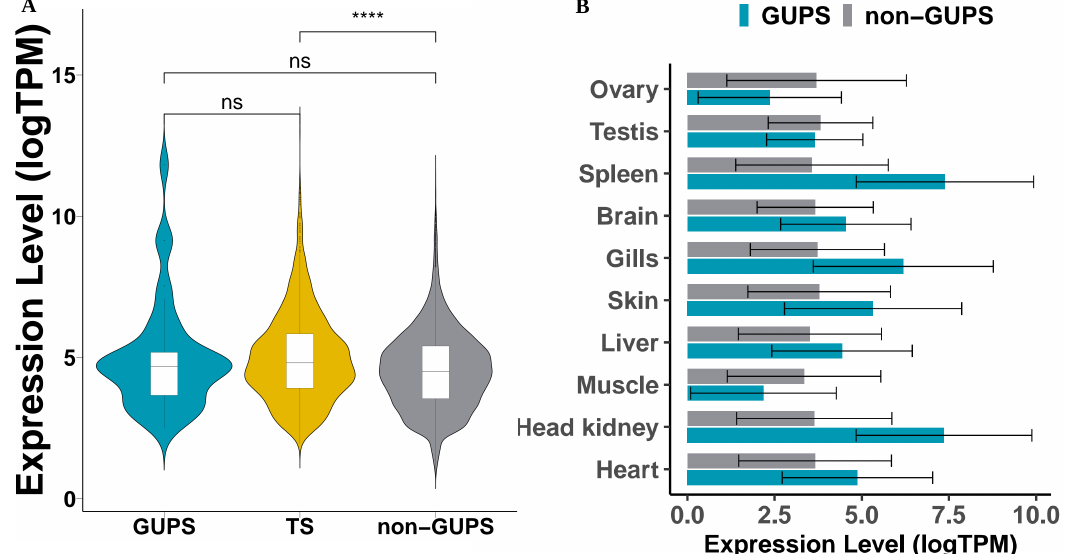
Figure 7. Expression levels of GUPS in pikeperch. ( A ), Violin plot comparing log transformed expression levels of GUPS, TS (Tissue-specific) and non-GUPS (all genes not under positive selection). The expression levels between GUPS and non-GUPS are not significantly different (Kruskal–Wallis-Test). ( B ), Log transformed mean expression of GUPS and non-GUPS in each tissue type. Statistical significance ns : Not significant; ****: Extremely significant ( p <